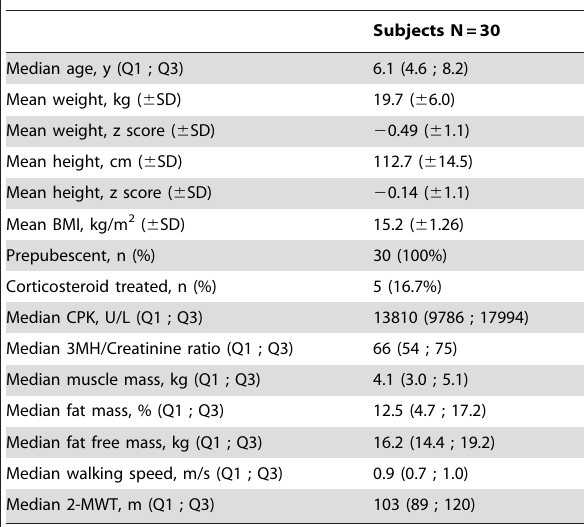
Table 1. Baseline